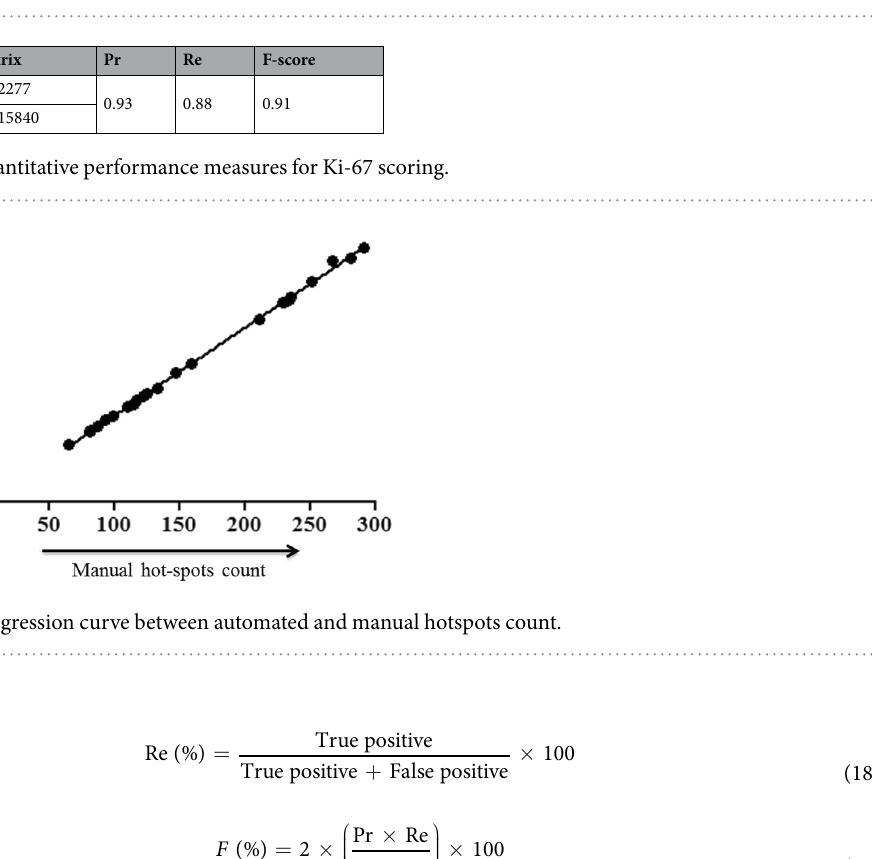
Table 4. Performance based on various combinations of training and testing dataset.